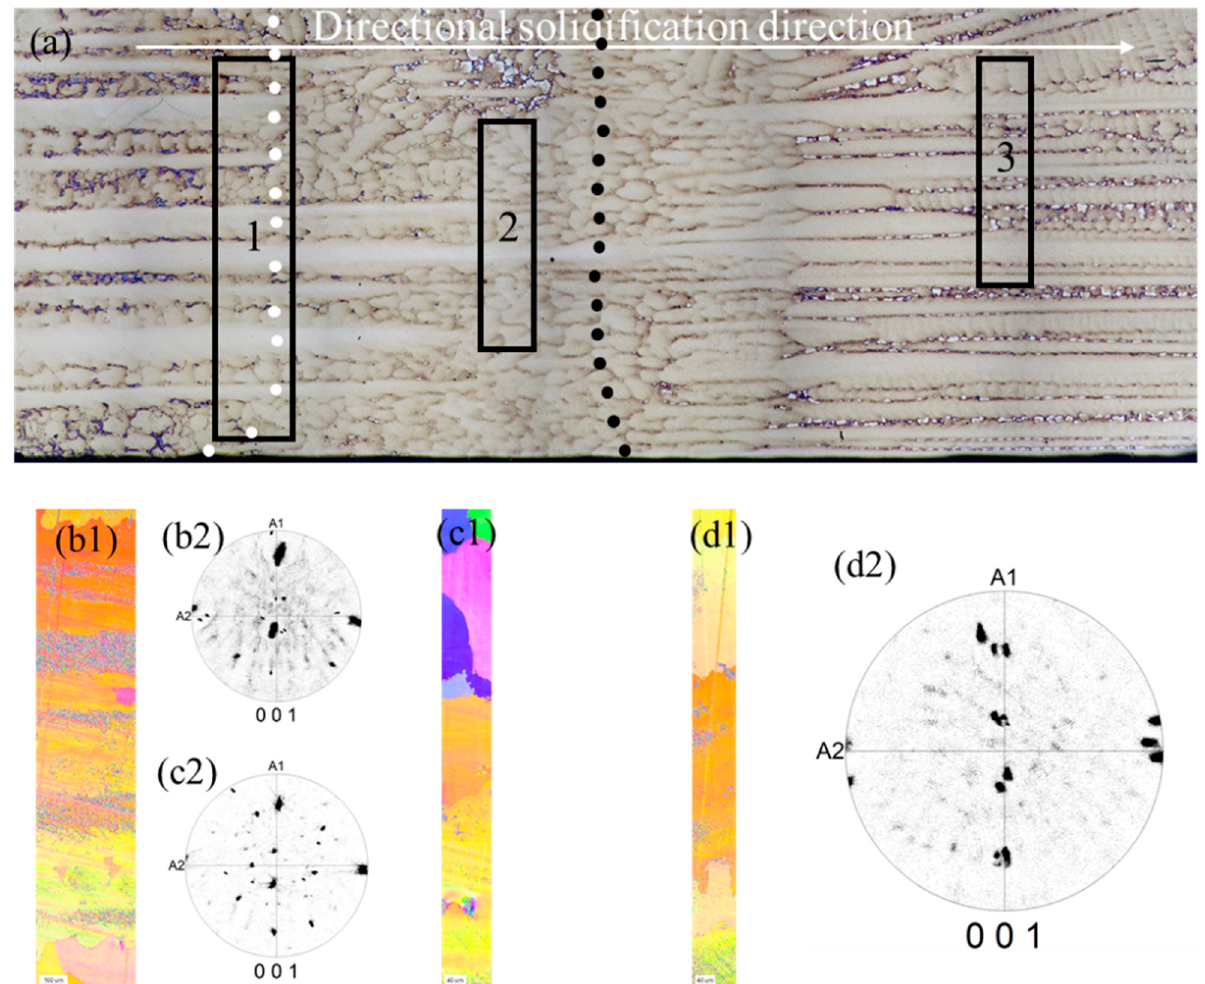
Figure 6. The metallographic microstructure and EBSD results detected by local area: ( a ) the longi- tudinal microstructure and EBSD maps and corresponding polar diagram tested in ( b1 , b2 ) zone 1, ( c1 , c2 ) zone 2, and ( d1 , d2 ) zone 3 in ( a ).